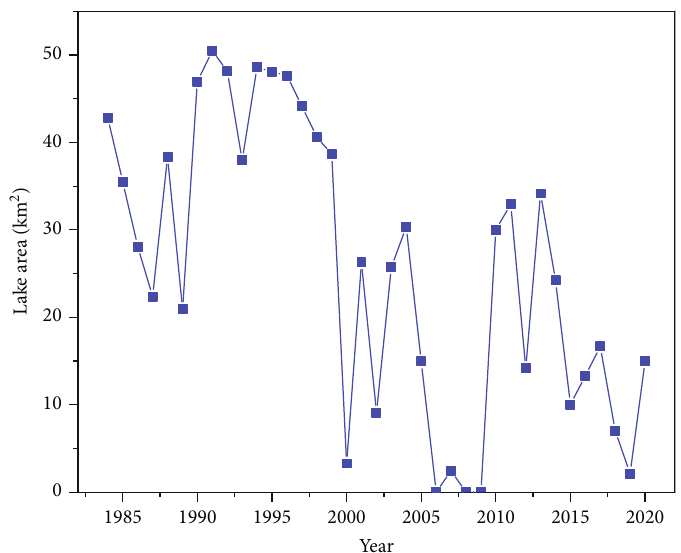
Figure 2: Evolution of Chahan Lake ’ s area from 1984 to